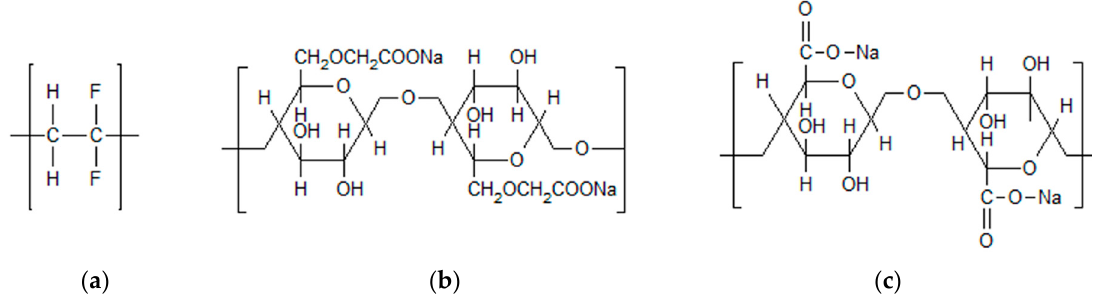
Figure 1. Chemical structures of ( a ) PVDF, ( b ) sodium carboxymethyl cellulose and ( c ) sodium alginate.